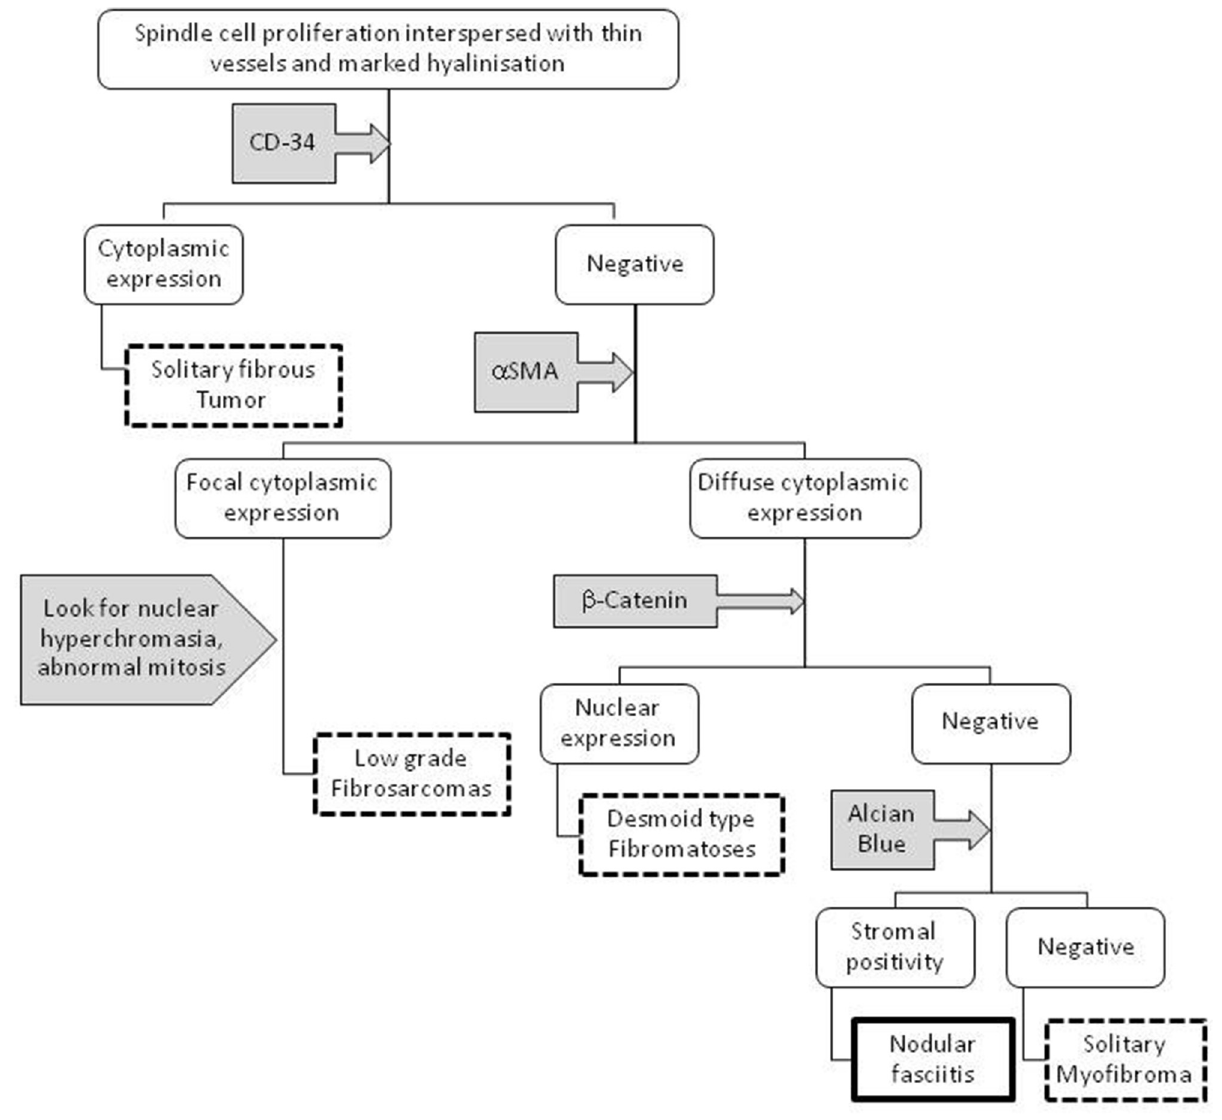
Fig. 4. A decision tree depicting the diagnostic